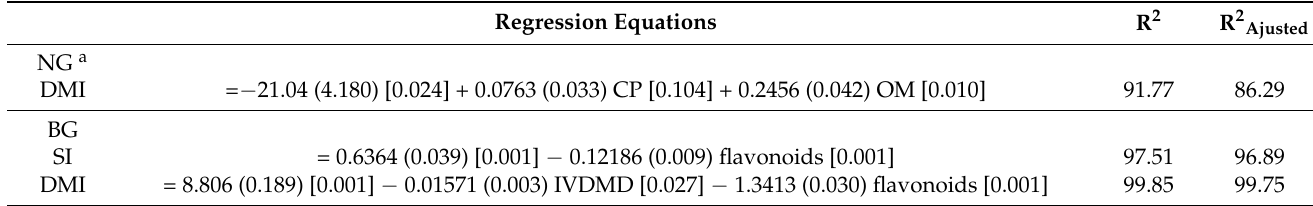
Table 6. Relationship between chemical composition factors of forage resources with selection index (SI) and intake (DMI/kg 0.75 ) in juvenile goats with and without browsing experience. Regression Equations R